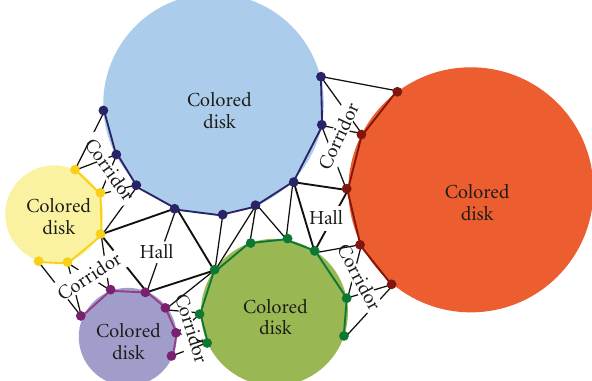
Figure 3: Colored disks, corridors, and halls. Note that points are not necessarily on the boundaries of the disks, but they are drawn this way to make the picture